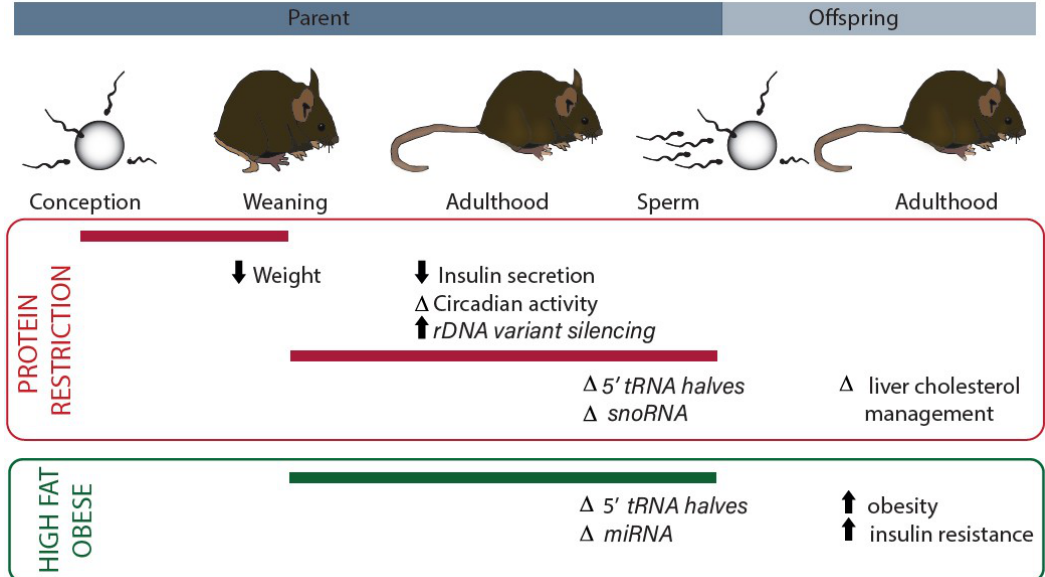
Figure 1. Summary of current evidence for dietary modulation of non-coding RNAs that contribute to the protein translation machinery. Dietary interventions have specific effects depending on the developmental period (indicated with reference to intergenerational life cycle by the solid bar). Studies of protein restriction are indicated in the red outlined panel. Studies of obesity/high fat diet are indicated in the green panel. Measured phenotypes are indicated along with the associated non-coding RNA changes (italics) (rDNA, ribosomal DNA; tRNA, transfer RNA; snoRNA, small nucleolar RNA; miRNA, microRNA).